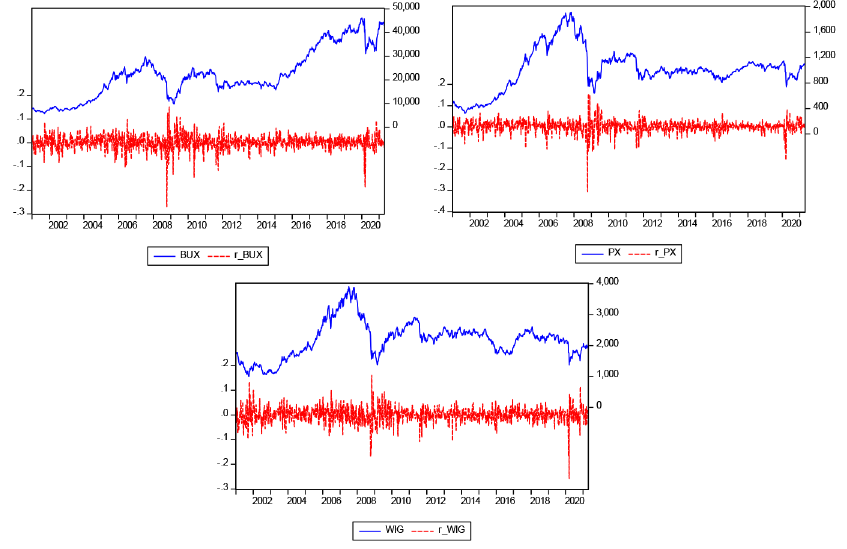
Figure 1. Development of stock indices and corresponding stock returns (prefix “r_“) (source: own calculations in